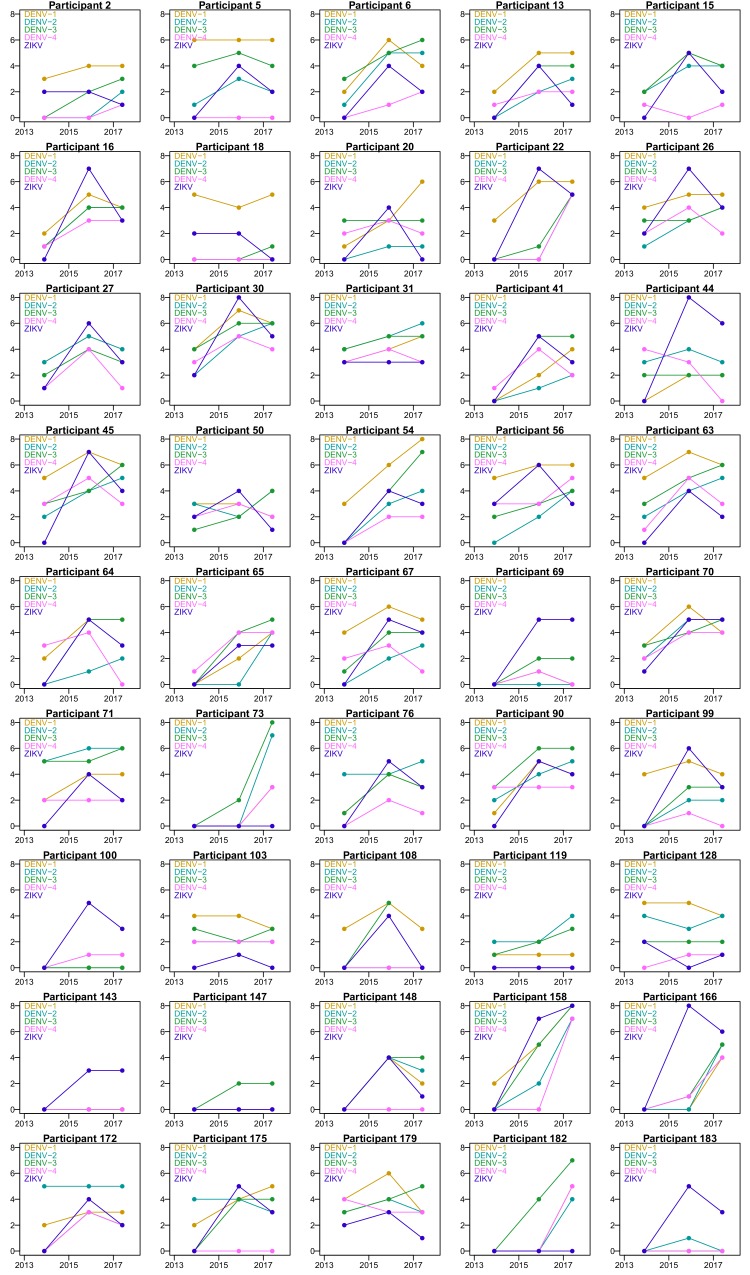
Individual-level neutralization log titres against the four DENV serotypes and ZIKV in Fiji.Points show assay results in the 2013, 2015 and 2017 sample collections for each participant, coloured by virus (n = 45).